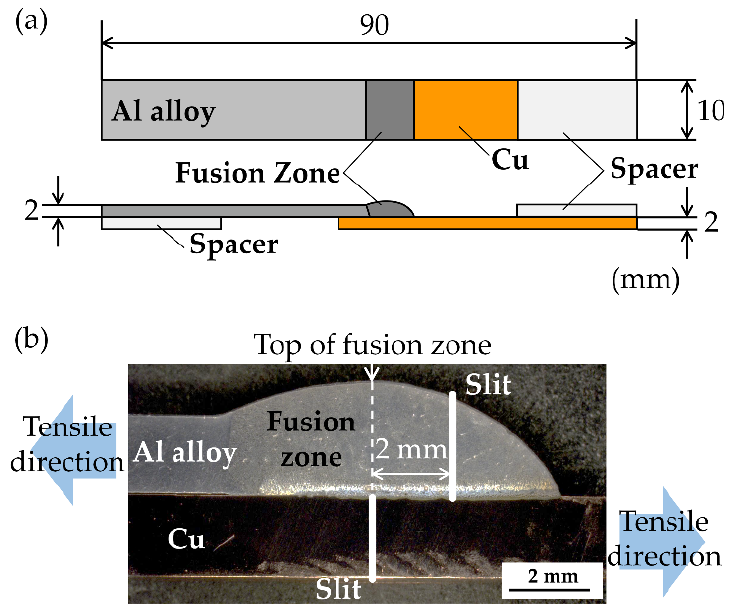
Figure 2. ( a ) Configuration and ( b ) location of the slits in the specimens used for tensile shear testing. E * was calculated from Equation (2) using the reduced modulus and mechanical properties of the